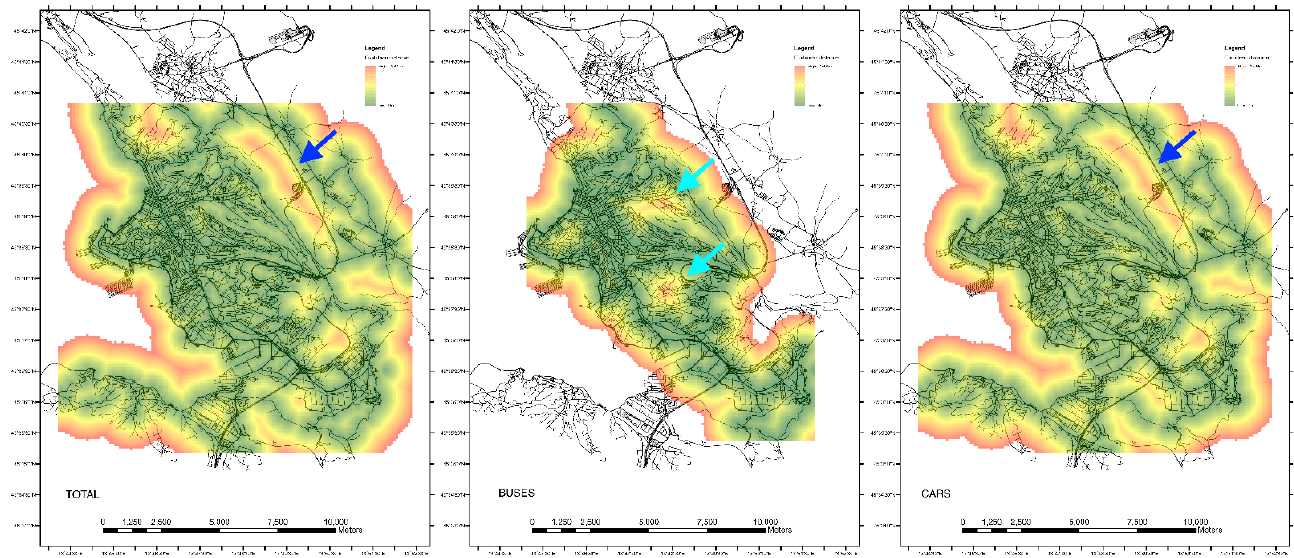
Figure 3. Maps of Euclidean distance in the designated area calculated using the (TOTAL) full dataset, (BUSES) buses-only dataset, and (CARS) cars-only dataset. Light blue arrows mark gaps in the geographic coverage of the dataset collected by buses only. These gaps can be in-filled using the dataset collected by cars. The blue arrows mark a steep slope zone where no road can be used to collect data and therefore remain uncovered.